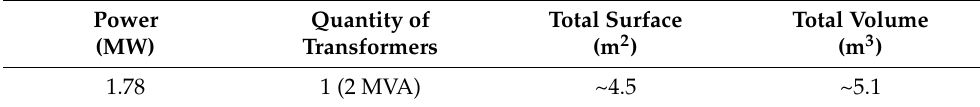
Table 14. Space requirements for a coupling transformer.